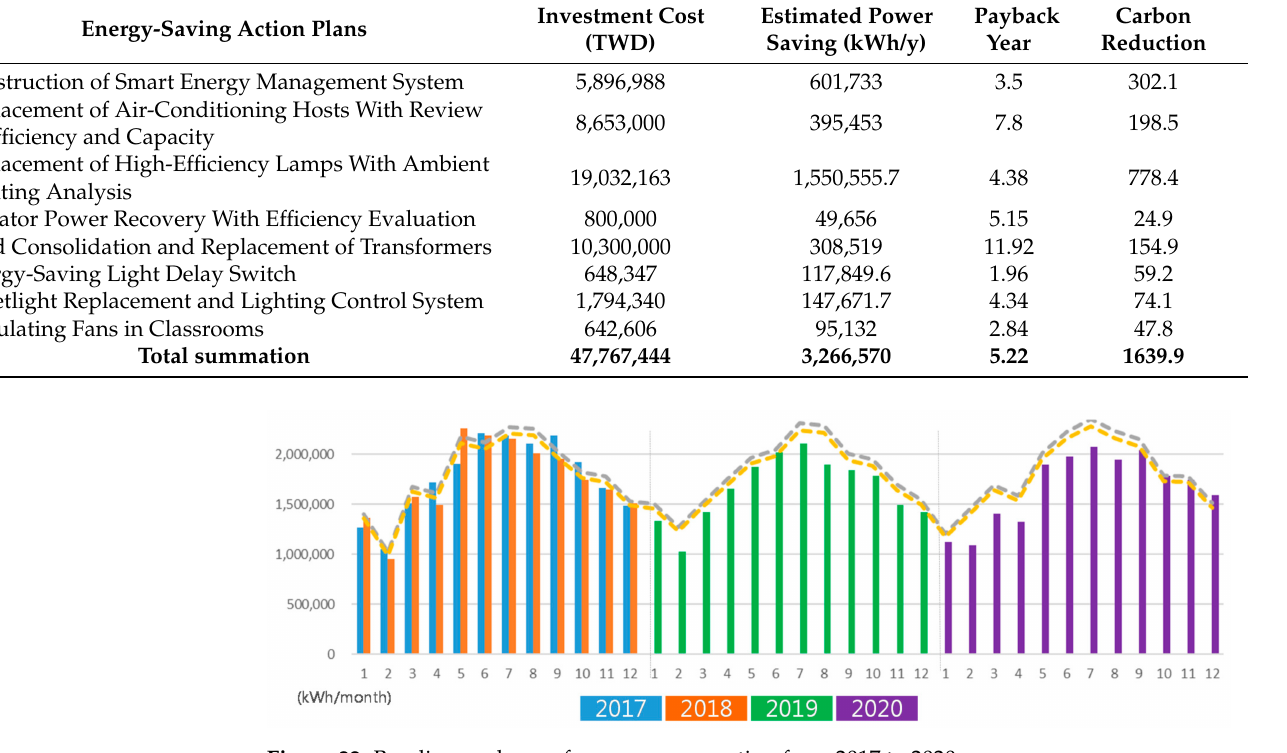
Figure 22. Baseline analyses of power consumption from 2017 to